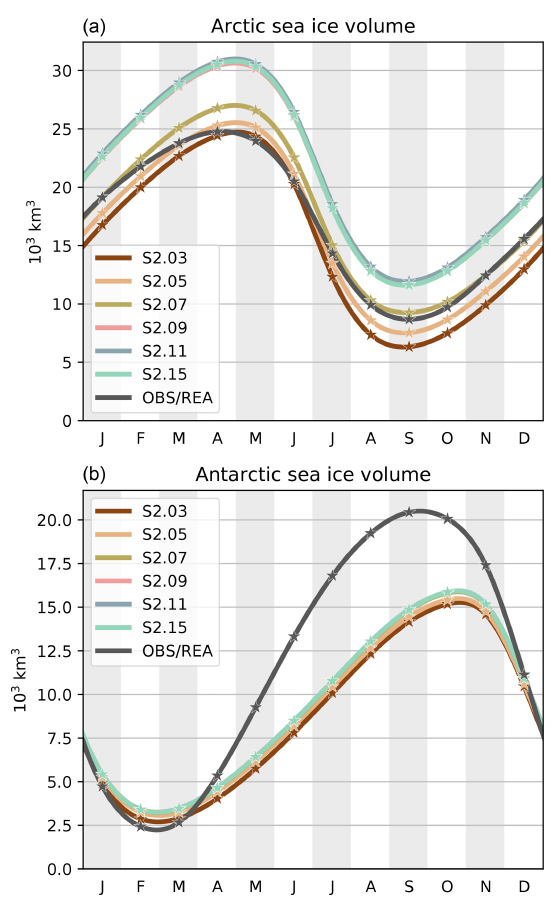
Figure 7. Mean seasonal cycles of Arctic (a) and Antarctic (b) sea ice volumes, over 1995–2014, in the second set of sensitivity ex- periments. Also shown are the Arctic and Antarctic ice volumes derived from the PIOMAS and GIOMAS reanalyses, respectively (Schweiger et al., 2011; Zhang and Rothrock, 2003). The stars show the monthly data and the curves are cubic interpolations between the data